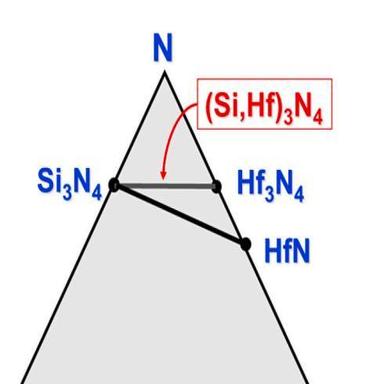
Thermodynamic guideline for the synthesis of high-pressure nitride (nano)composites in the ternary system SiHfN.